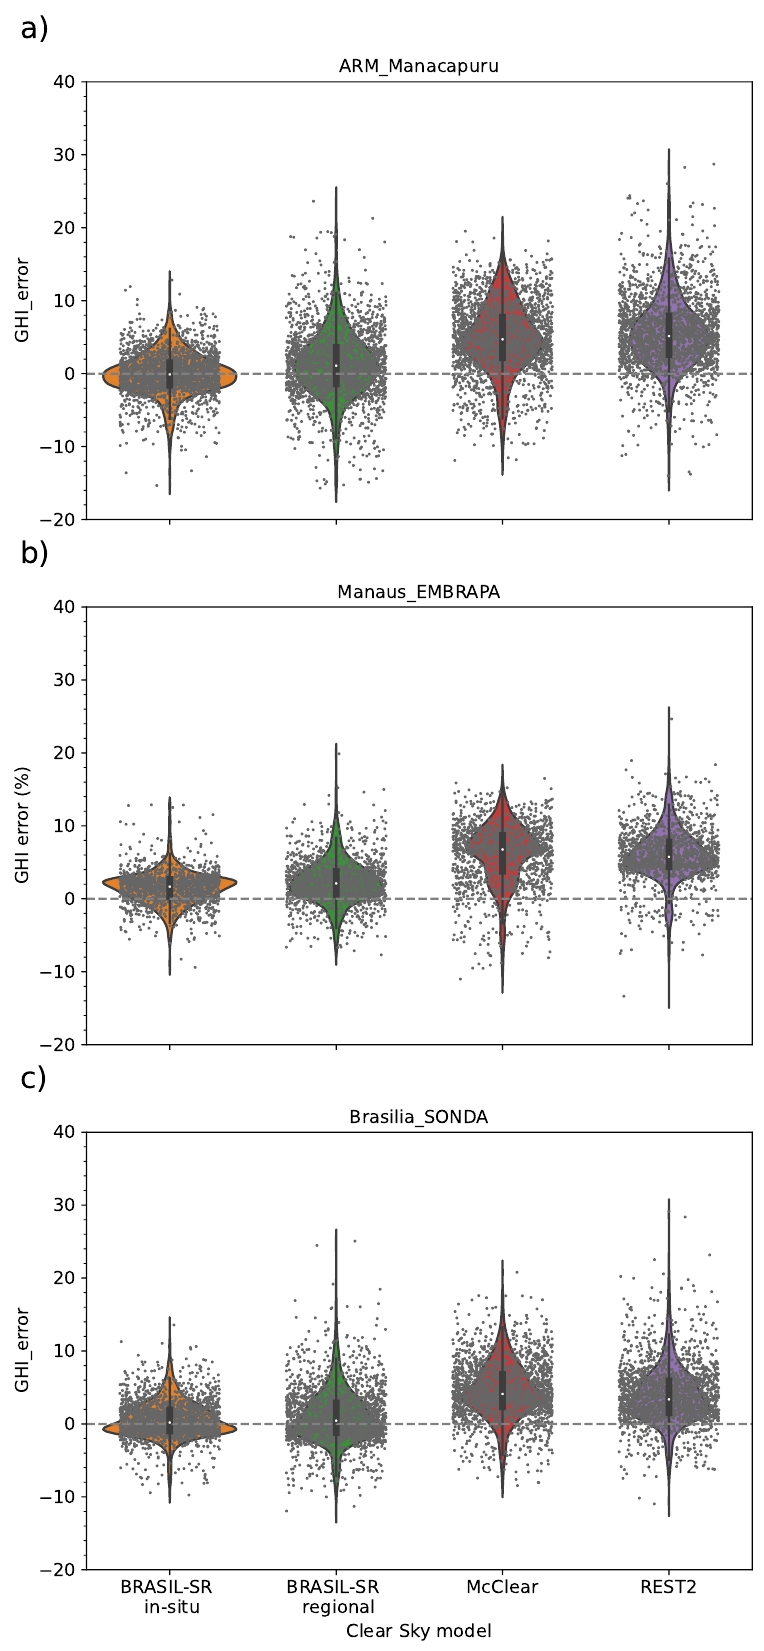
Figure 6. Combined violin and strip plots of the deviations of the BRASIL-SR GHI outputs in in-situ and regional experiments , McClear ans REST2 for ARM_Manacapuru ( a ), Manaus_EMBRAPA ( b ) and Brasilia_SONDA ( c